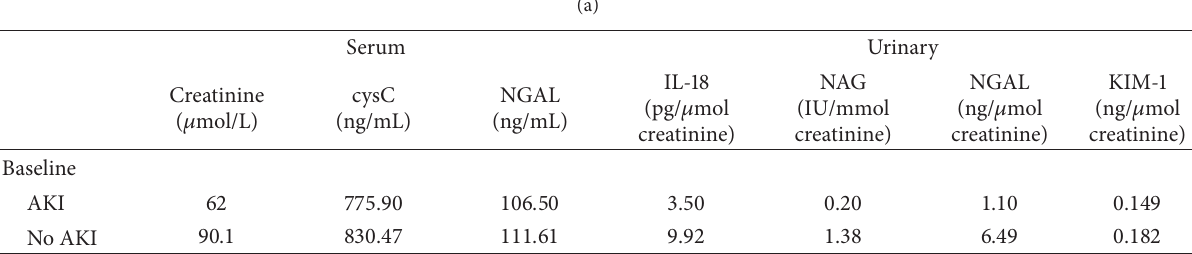
Table 4: (a) Baseline values and (b) percent variation from baseline at 3, 24, and 72 hours postcontrast media exposure in the patient who developed AKI, as opposed to those who did not.